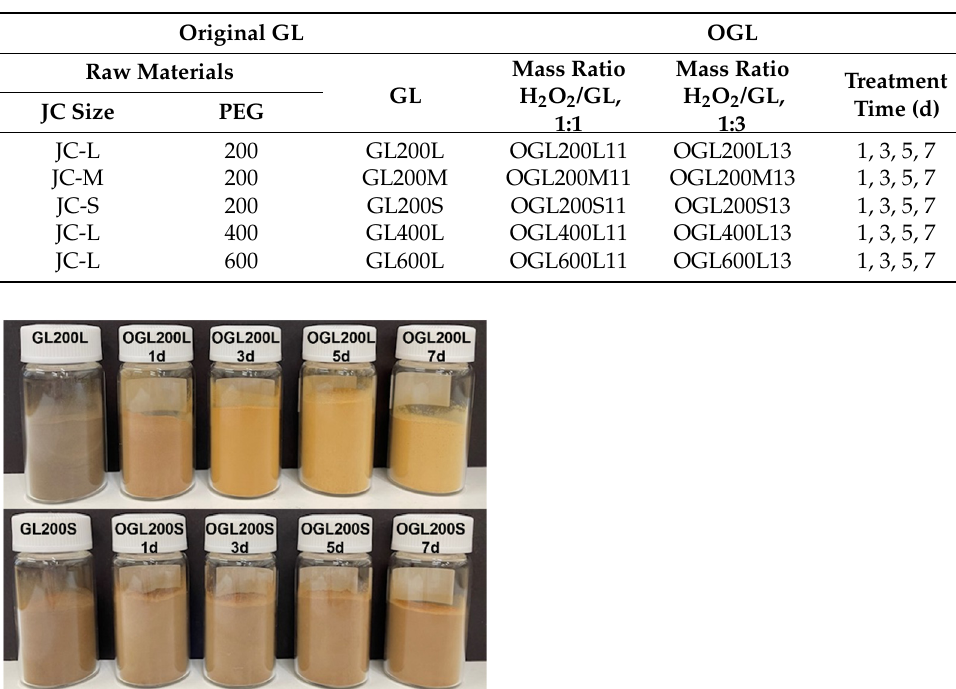
Table 1. GL samples and corresponding OGLs samples.